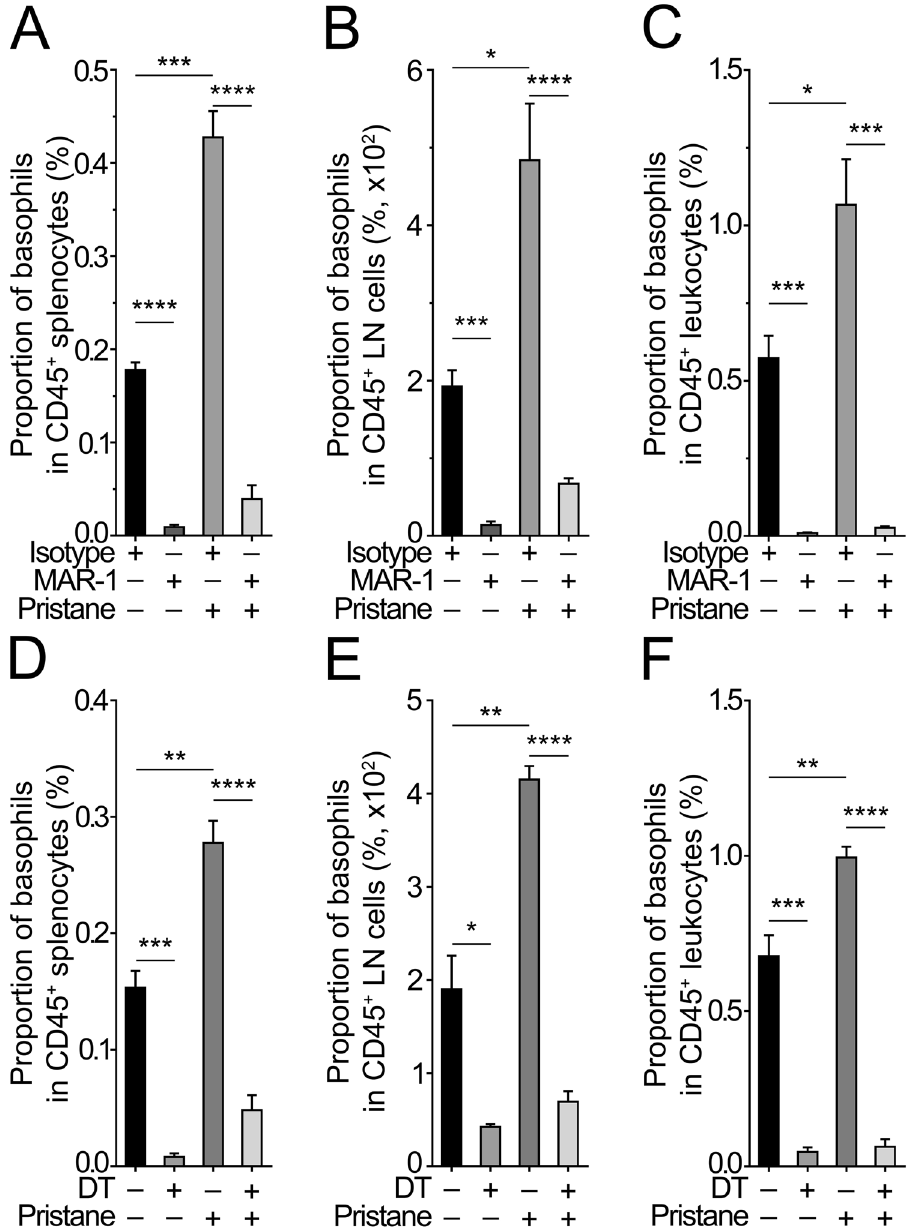
Figure 2. Efficient basophil depletion induced by Mar-1 antibody or diphtheria toxin. ( A – F ) Proportion of basophils among CD45 + cells (as described in Fig. 1) in spleen ( A , D ), lymph nodes ( B , E ) and blood ( C , F ) as determined by flow cytometry, in mice described thereafter. ( A – C ) PBS- or pristane-injected C57BL/6 mice basophil-depleted or not through treatment with MAR-1 antibody or isotype control, respectively, as described in the Methods . ( D – F ) PBS- or pristane-injected C57BL/6 Mcpt8 DTR mice basophil-depleted or not through treatment with diphtheria toxin (DT) or PBS, respectively, as described in the Methods . Data acquisition was realized by flow cytometry. Data correspond to the pooled results of at least three independent experiments. Per group, n = 3–8 mice. Data are presented as mean + s.e.m. Statistical analyses were by unpaired Student t tests. NS, not significant; * p < 0.05, ** p < 0.01, *** p < 0.001, **** p <